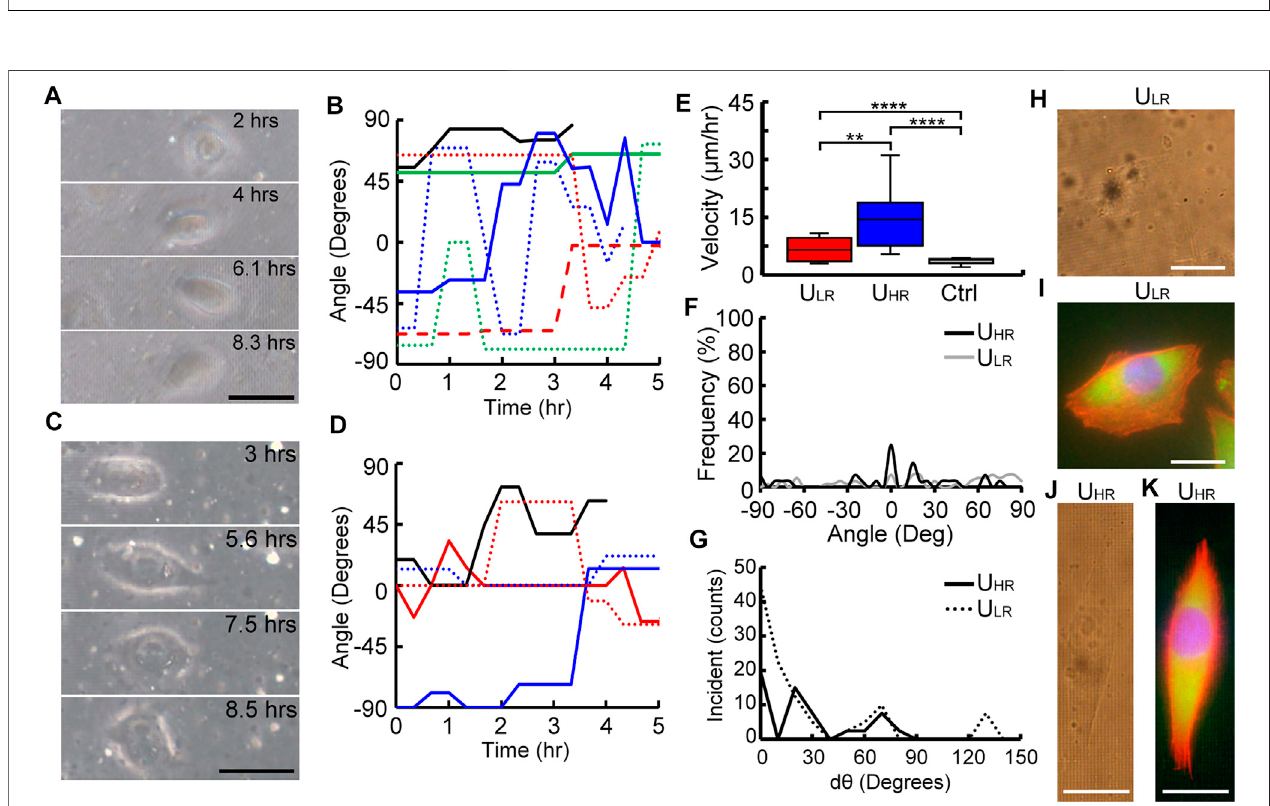
FIGURE3| Analysisofcellmigratorybehaviors onuniform substrates. Time-lapse images and tracesoforientationangleofcellsmigratedonULR (A – B) andUHR (C – D) substrates. Comparison of range of migrating velocity (E) , orientation frequency (F) , the change of orientation angle d θ (G) , and phase contrast and fl uorescent micrographs of cells migrated on ULR (H – I) and UHR (J – K) substrates, where nuclei, F-actin, and focal adhesion complex were stained with H33342 (Blue), rhodamine phalloidin (orange – red), anti-vinculin antibody, and anti-paxillin antibodies (green) Scale bar =100 µm.